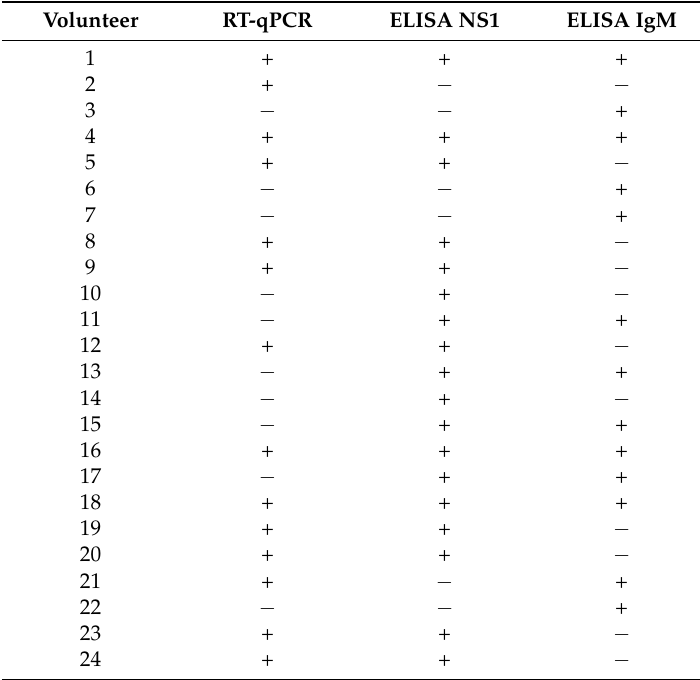
Table 1. Profile of molecular and serological tests of